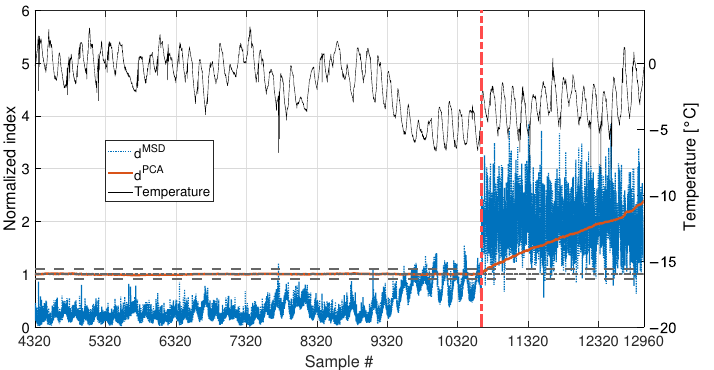
Figure 20. Comparison between d MSD (blue dotted line) and d PCA (red solid line), with b = 4320, con- sidering a real temperature trend (black thin line) and damage (30% reduction of Young’s modulus).